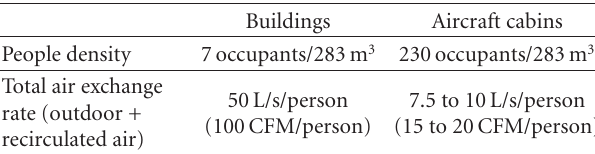
Figure 1: Outside air changes per hour in di ff erent environments [10]. Table 1: Typical values for people density and total air exchange rates